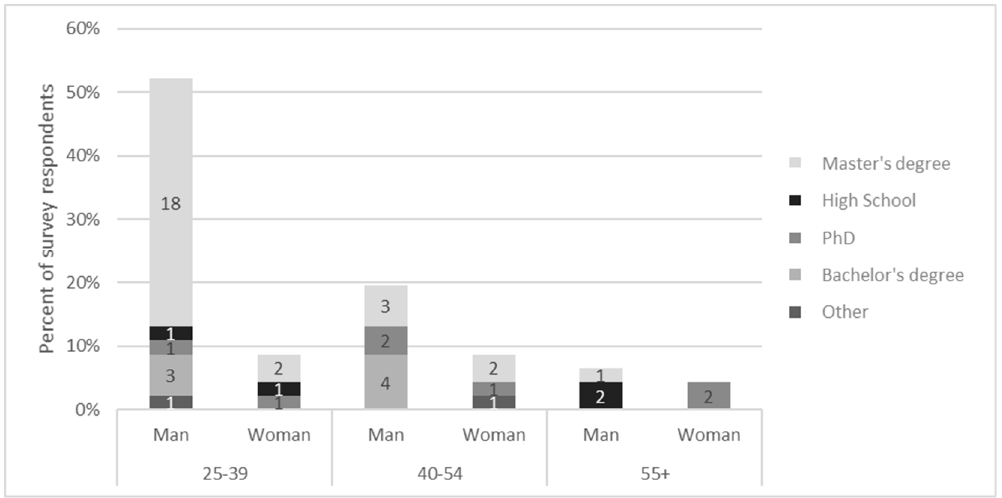
Figure 1. Age range, sex, and education level of the respondents.